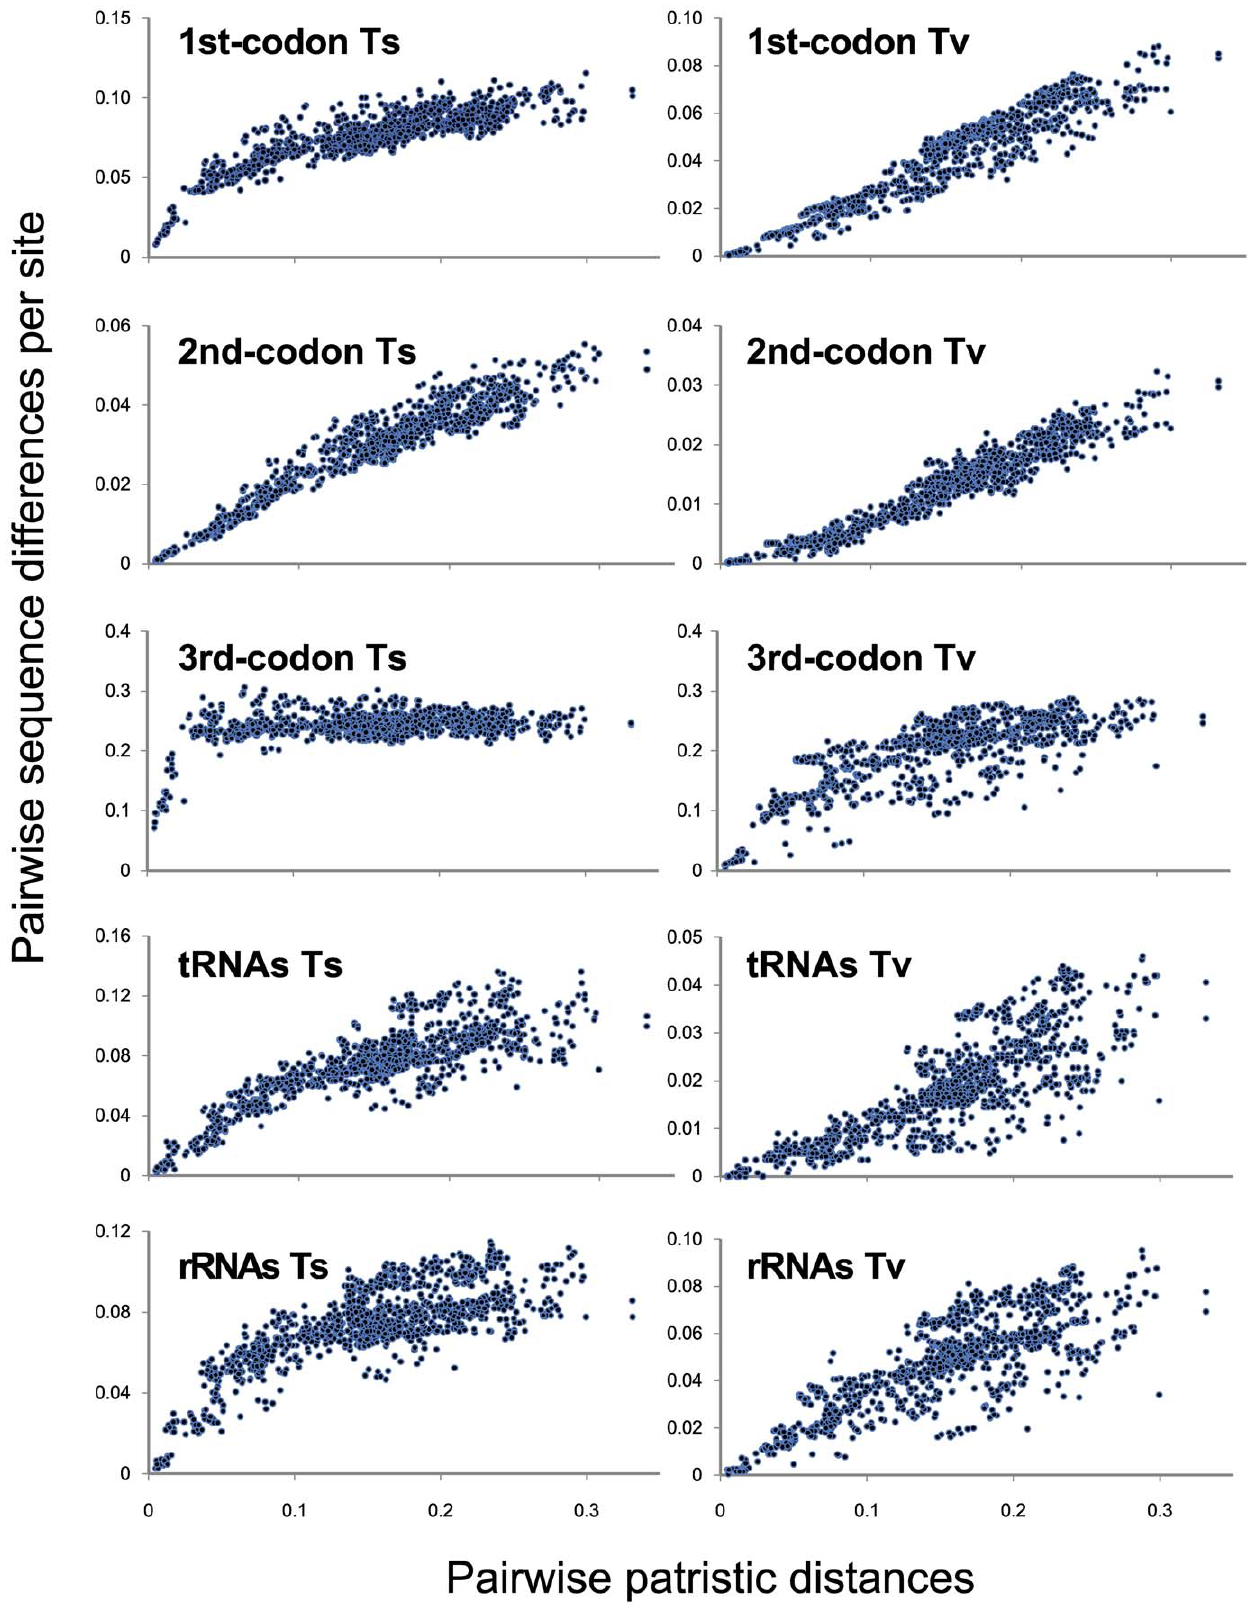
Figure 2. Patterns of sequence variation in the mitochondrial genomes of 45 tetraodontid pufferfishes and five outgroups. Pairwise transitional (TS) and transversional (TV) substitutions per site were plotted against pairwise patristic distances as a substitute for absolute geological time. Gamma-corrected maximum likelihood distances calculated using the mtREV + F model [78] and derived from deduced amino acid sequences for the 13 protein-coding genes were used for evolutionary distances. doi:10.1371/journal.pone.0017410.g002 PLoS ONE | www.plosone.org 4 February 2011 | Volume 6 | Issue 2 |